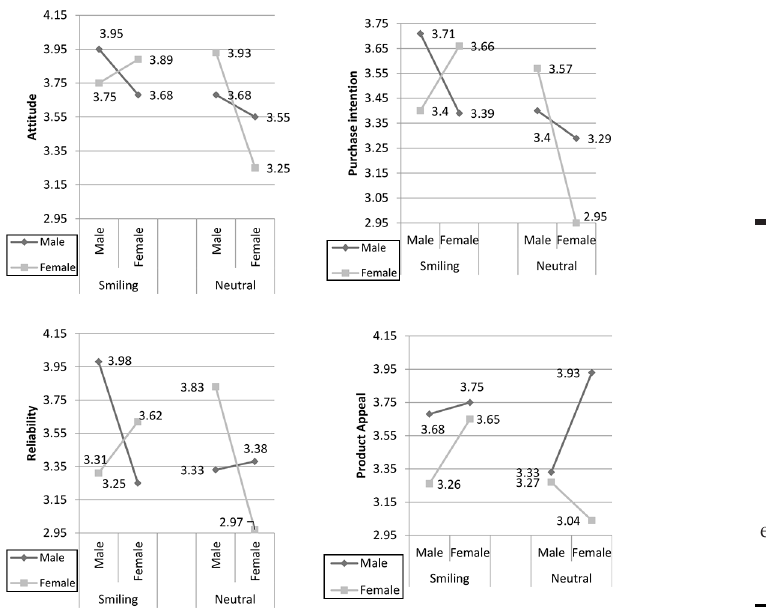
Figure 3. Interaction of facial expression (cid:1) model ’ s gender (cid:1) viewer ’ s gender